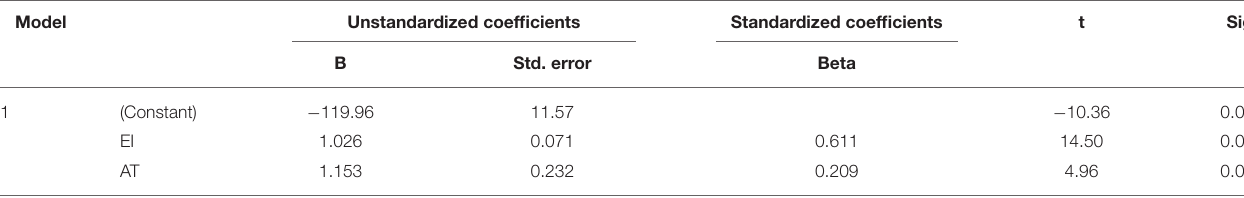
TABLE 7 | Coefficients for work engagement, emotional intelligence, and ambiguity